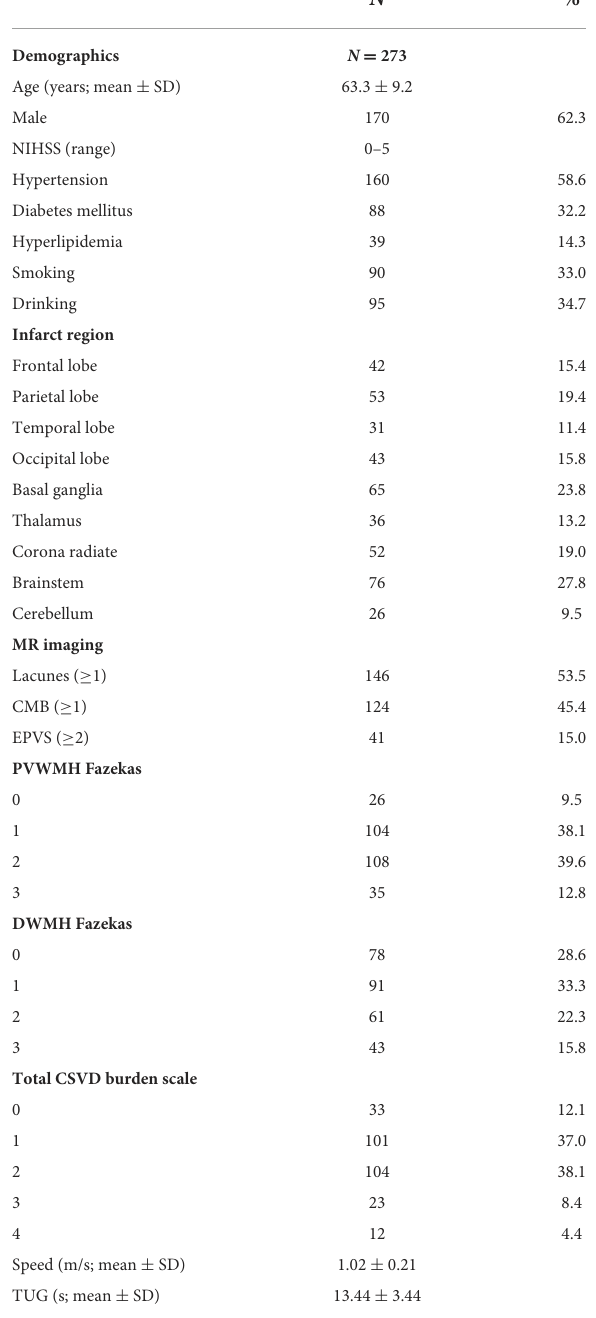
TABLE 1 Baseline characters of subjects included in the